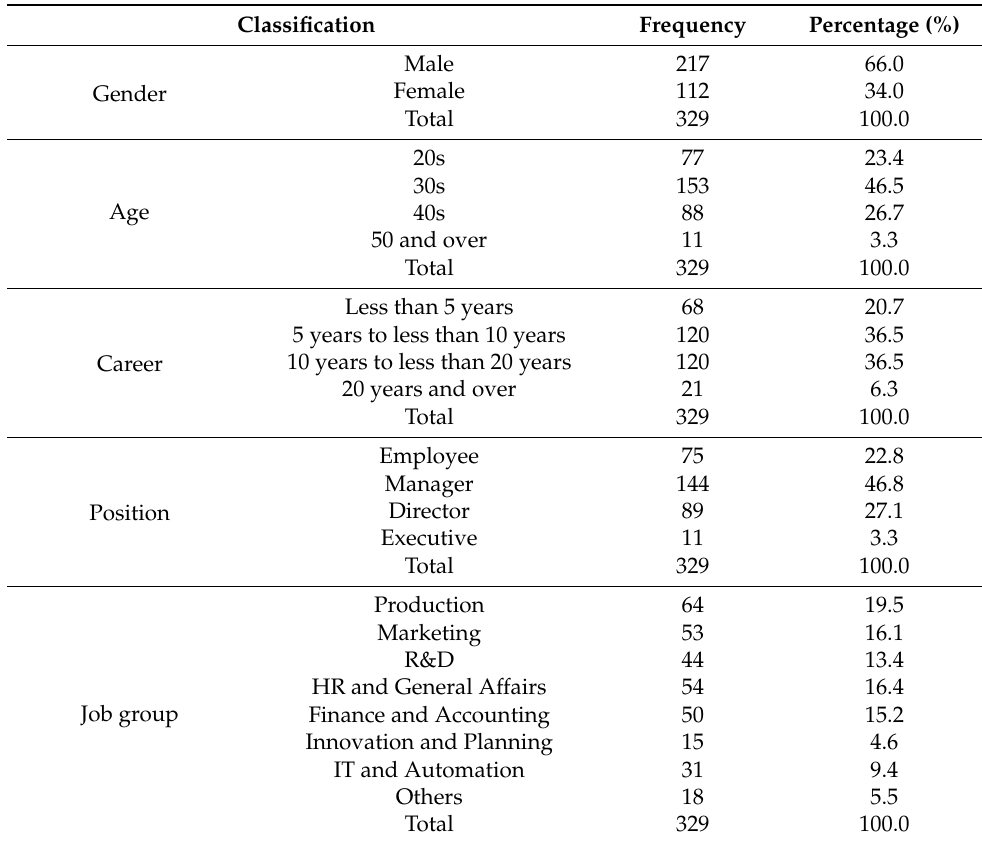
Table 3. Demographic information of survey